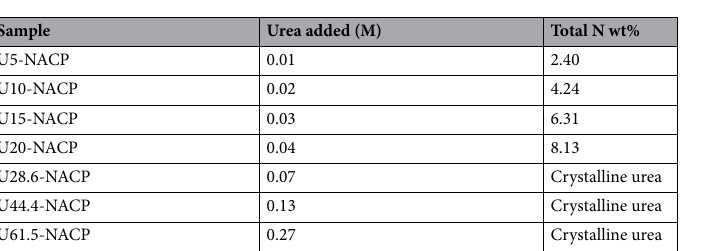
Figure 1. ( a ) X-ray powder diffractograms of pure crystalline urea (black line) and U-20-NACP material (orange line). Inset: X-ray diffractograms (2θ from 20° to 25°) of U-doped materials. ( b ) FT-IR spectra of pure crystalline urea (black line) and U5-NACP, U10-NACP, U15-NACP and U20-NACP materials. The absorption bands of urea are highlighted in yellow.